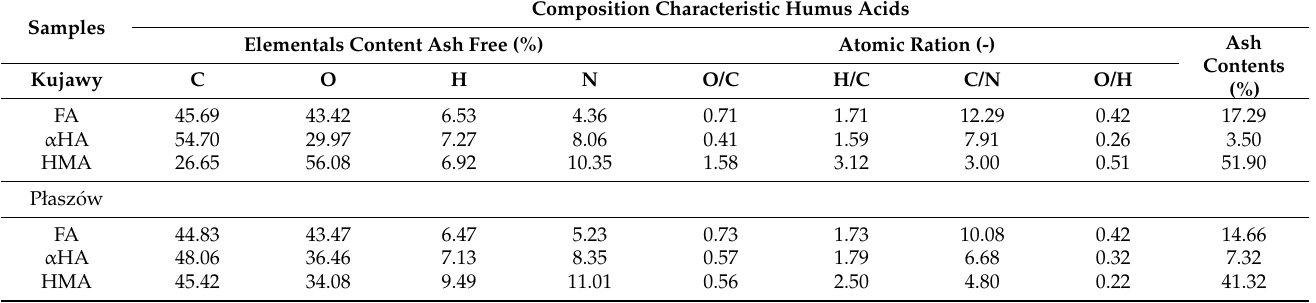
Table 3. Elemental composition and its atomic ration for the extracted humus acids. Kujawy & Płasz ó